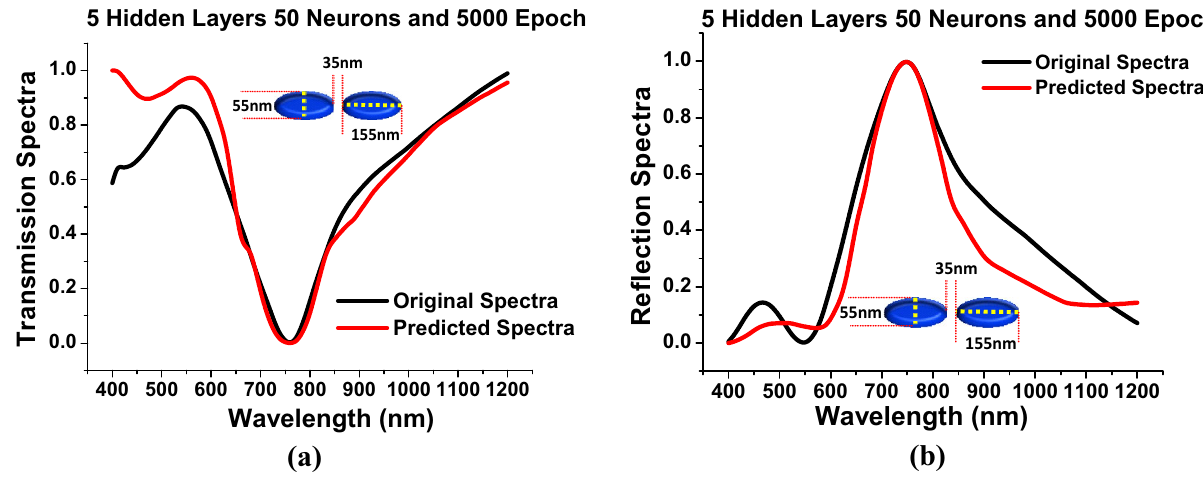
Figure 10. Hidden layer = 5, Neurons = 50 and Epoch = 5000 ( a ) Shows the comparison between the predicted transmission spectra against the original transmission spectra. ( b ) Shows the anticipated reflection spectra are compared to the original reflection spectra when a = 155 nm, b = 55 nm, g = 35 nm and h = 40